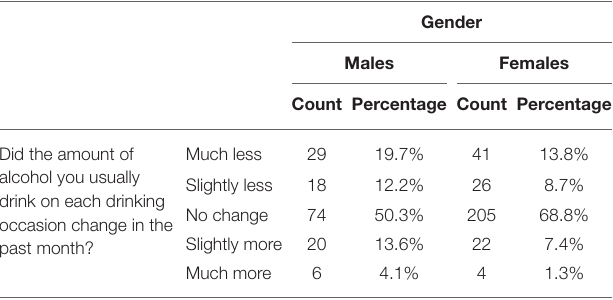
TABLE 2 | Distribution of answers: amount of alcohol.